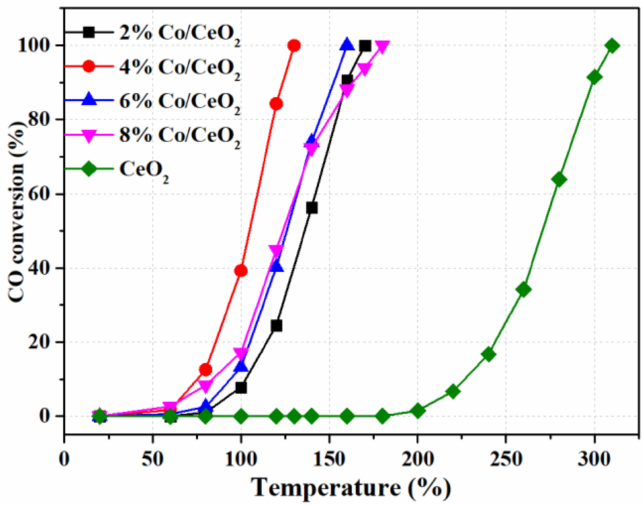
Figure 1. CO conversion as a function of Co loading for the catalysts produced by the hydrothermal method.